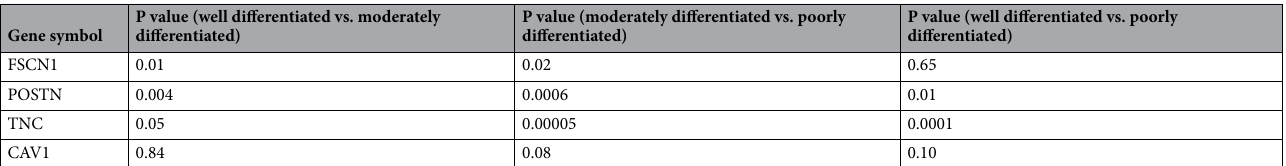
Table 8. p-values of genes in various comparative grades.